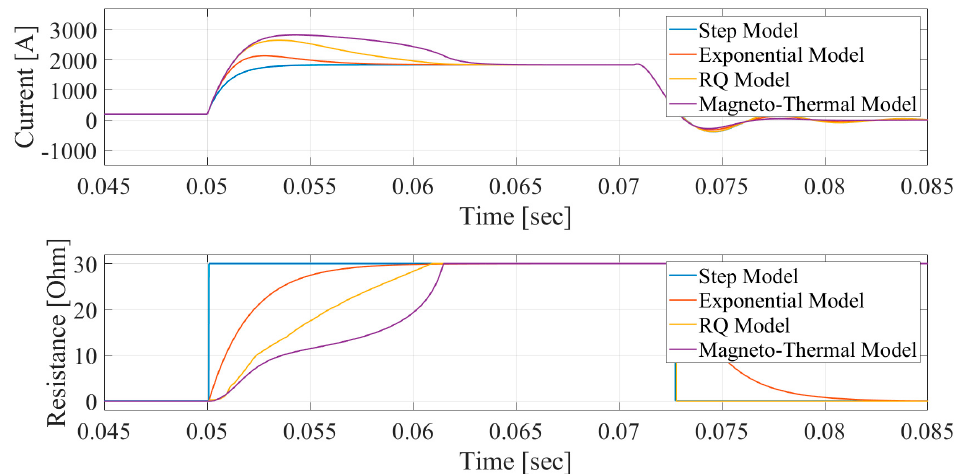
Figure 13. Model comparison for 300 A critical current and 15 Ω fault resistance.